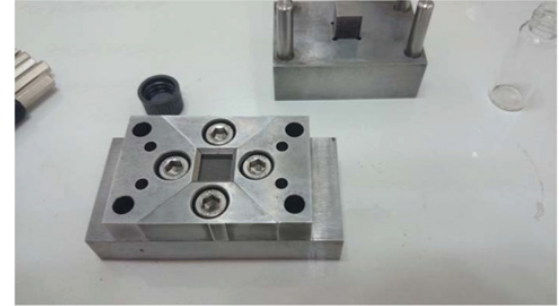
Figure 4. Pressurizing die.